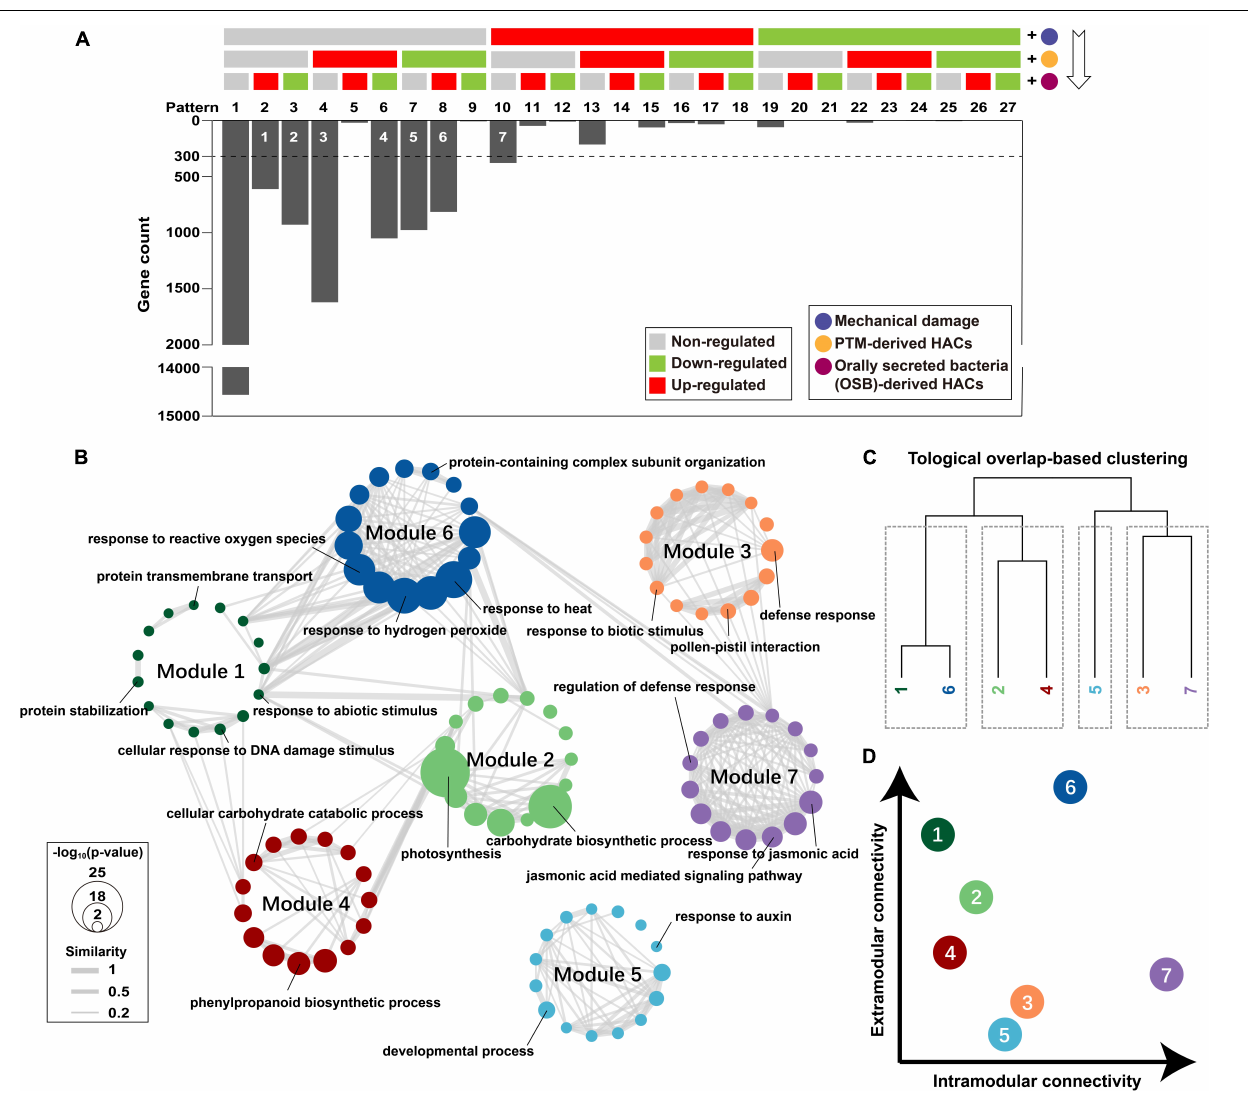
FIGURE 5 | Dissecting how potato plants integrate responses to stimuli of different PTM herbivory components. (A) Seven robust gene modules associated with different components were identified (white number on the bars). The regulated genes were identified via DEG analysis every time component was added; and 300 was set as a threshold of minimal module size. (B) Top 15 overrepresented biological process GOs of each gene module were integrated as a functional network. Node refers to the GO term, and the edge refers to that two GOs were functionally connected; p -value of overrepresentation analysis is mapped to node size; Jaccard similarity between two GO terms is mapped to edge width; gene module is mapped to node color. (C) Gene modules were clustered based on topological overlap; it cut gene modules into four clusters. (D) The intramodular connectivity and extramodular connectivity of gene modules are displayed as a dot